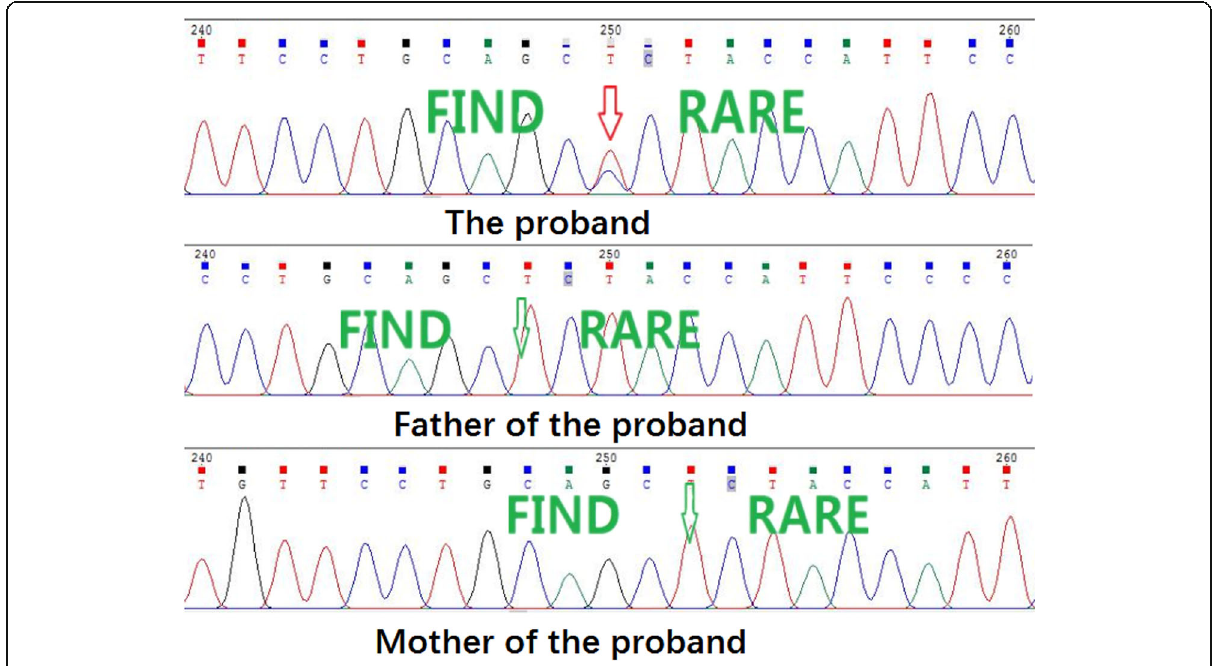
Fig. 4 Heterozygous TSC2 :c.4511 T > C variant (arrow) was identified in the paternal sample (proband) but not in his